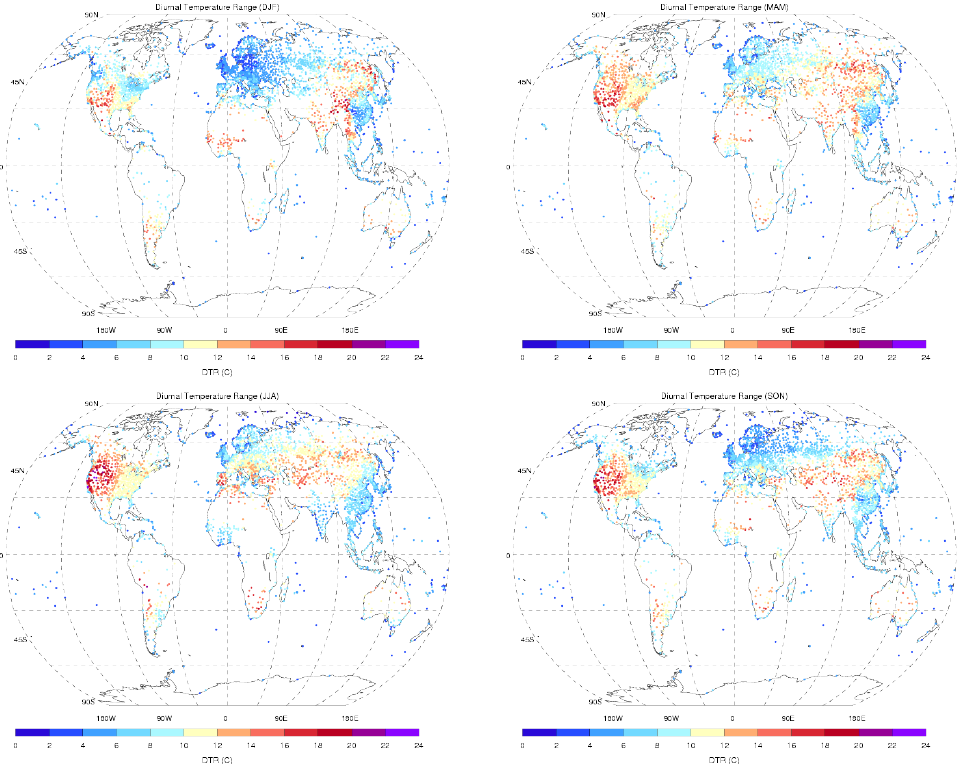
Fig. 22. The median diurnal temperature ranges recorded by each station (using the selected 3427 stations) for each of the four three-month seasons. Top-left for December-January-February, top-right for March-April-May, bottom-left for June-July-August and bottom-right for September-October-November.